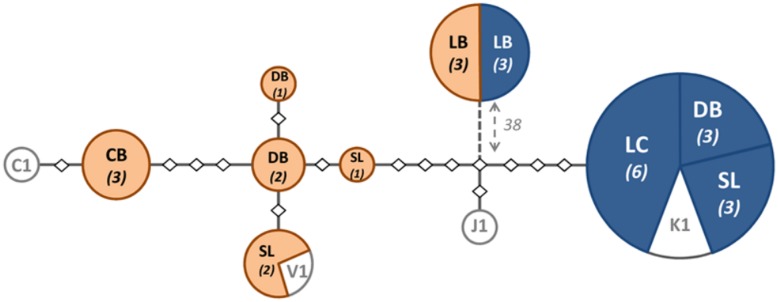
Varroa coxI haplotype divergence in the Philippines and Vietnam.Network representing the amount of substitutions between the different coxI sequences obtained from different Varroa mites sampled in colonies of A. mellifera (in blue with white text) and A. cerana (in orange with black text). The mites were sampled in Vietnam in the surrounding of Dien Bien (DB), Son La (SL) and Cat Ba (CB) and in the Philippines in the city of Los Banos (LB) and Lipa City (LC). The sample size for each haplotype is written in italic between brackets below the sampling location. The grey components represent additional accessions generated by Navajas et al. (2010): AmK1-1 haplotype (K1, accession GQ379056), AcV1-1 (V1, accession GQ379061), AcC1-1 (C1, accession GQ379065) and AmJ1-6 together with AcJ1-4 (J1, accessions GQ379074.1 and GQ379072.1, respectively). Each diamond represents a substitution. The number indicated close to the dotted line represents the number of substitutions not represented on the figure.